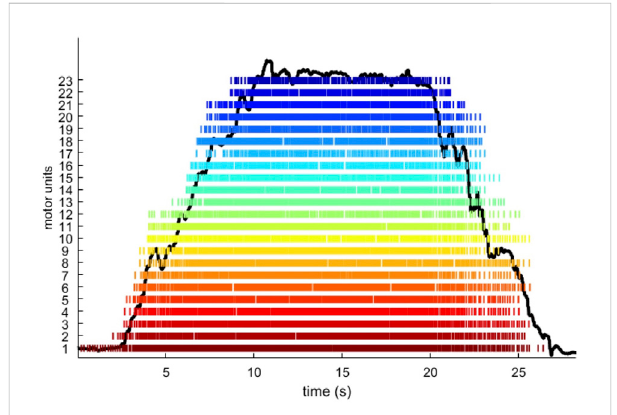
FIGURE 1 An example of a trapezoidal ramp. Representative trapezoidal ramp at 35% MVF with a rate of force increase of 5%MVF · s 1 of participant number 11. Each stripe corresponds to a single motor unit, and each stick within the stripe corresponds to a motor unit fi